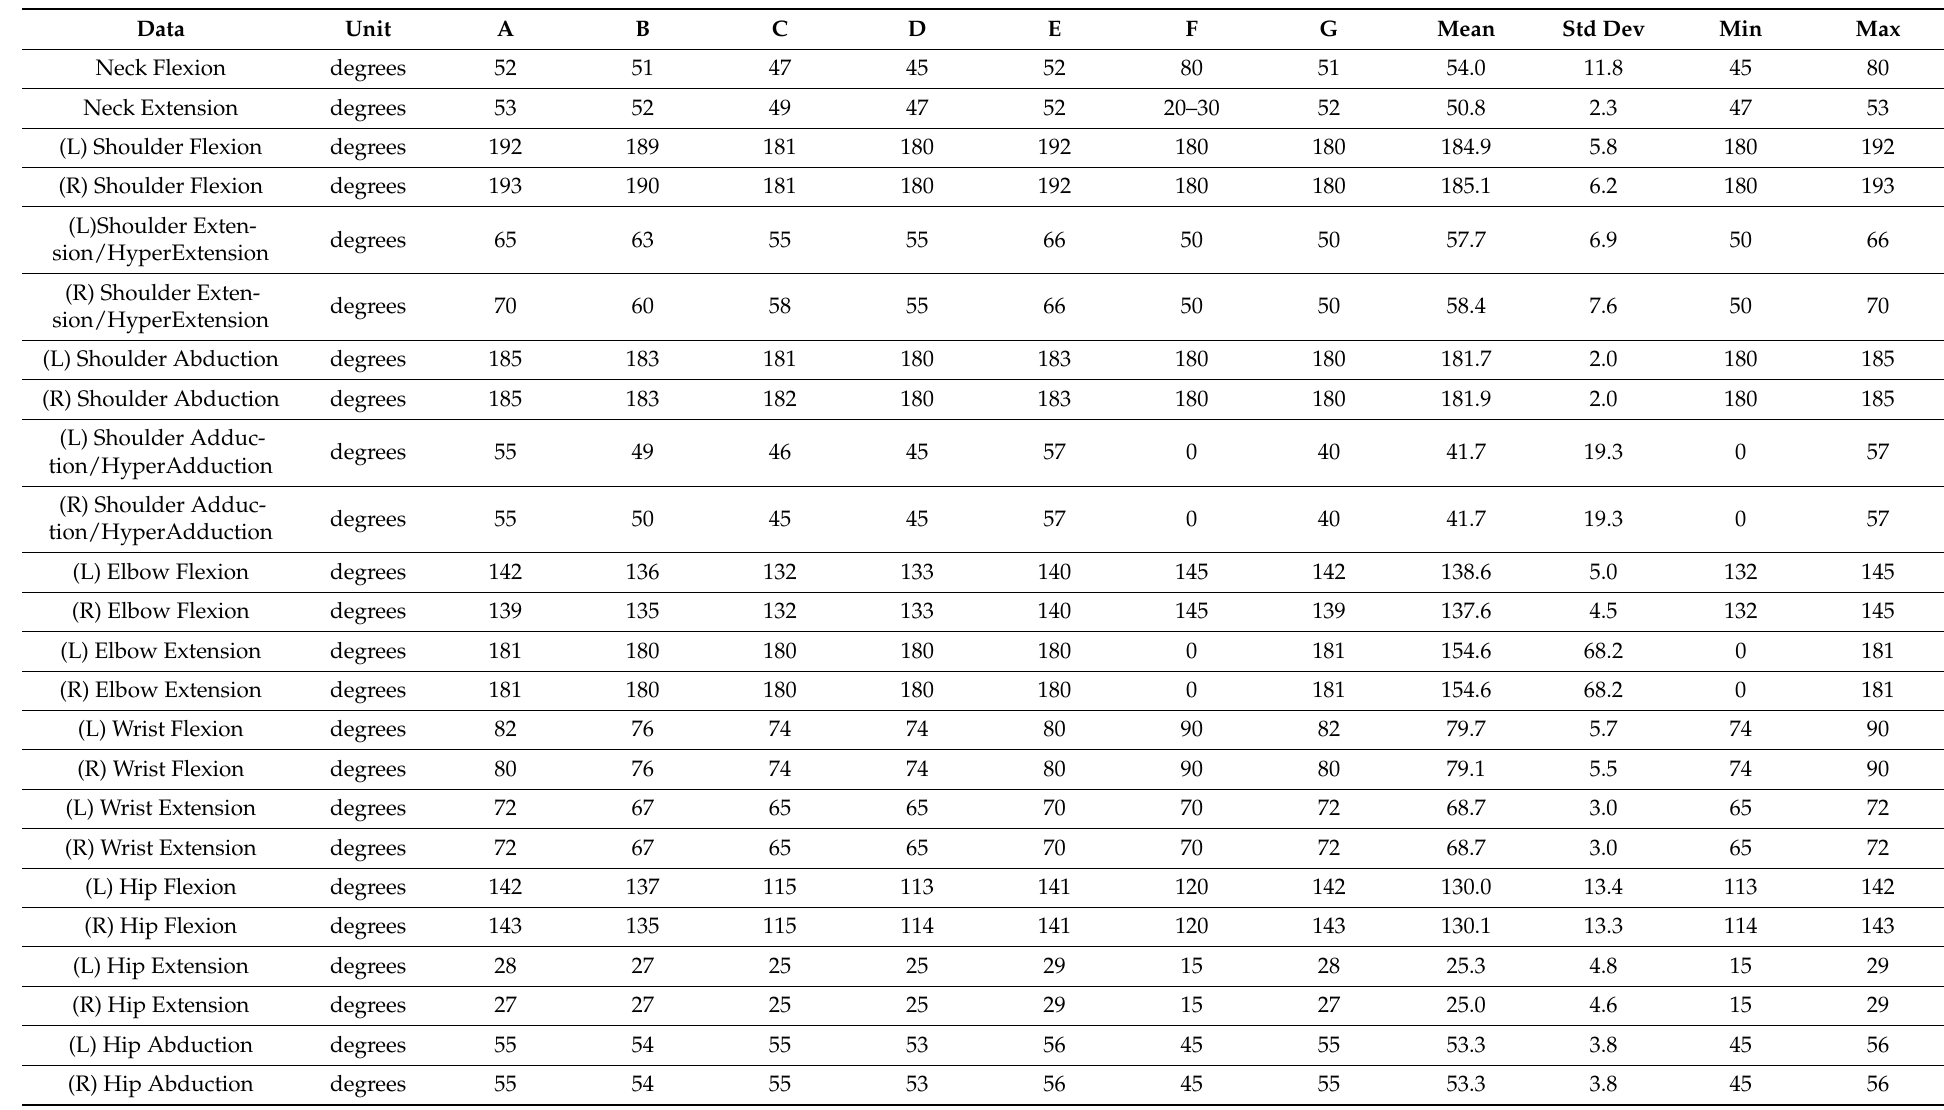
Table 2. Functioning: range of motion